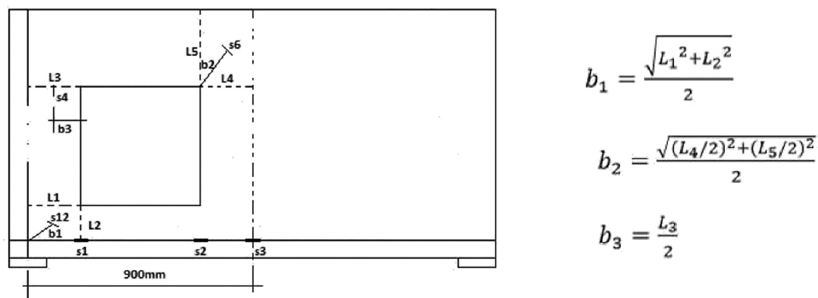
Figure 4: Locations of strain gauges on steel rebars and concrete